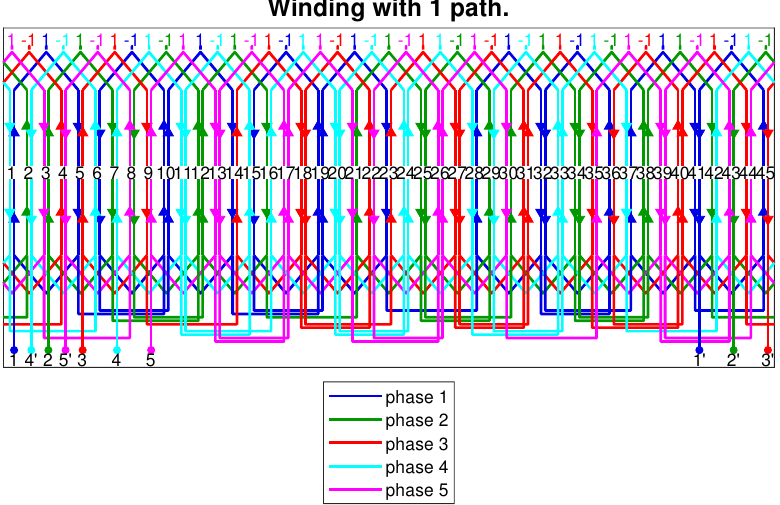
Figure 5. Goerges polygon for a five-phase machine with N = 45, p = 5 and y = 2. Winding with 1 path.